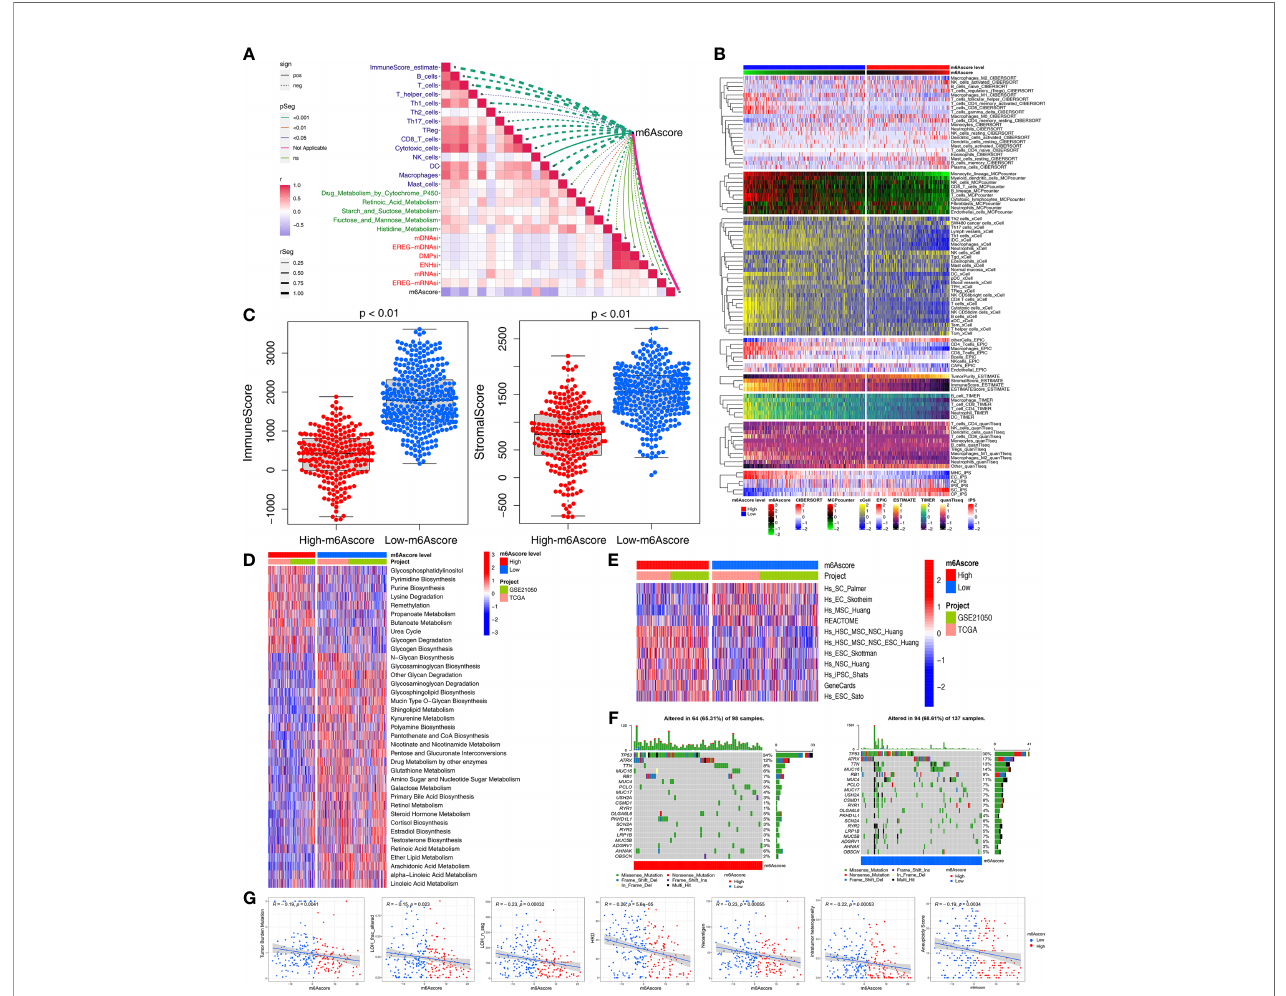
FIGURE 4 | Multiomics analysis of the role of m6Ascore. (A) Correlations between m6Ascore and immune cells, metabolic pathways and stemness index, respectively. (B) Heatmap for immune responses based on CIBERSORT, MCPcounter, xCell, EPIC, TIMER, quanTIseq and iPS algorithms the low- or high- m6Ascore groups. (C) Differences in immuneScore and stromalScore from ESTIMATE algorithms between low- or high-m6Ascore group in the TCGA-SARC and GSE21050 cohort using Kruskal – Wallis test. (D, E) GSVA enrichment analysis showing the activation states of metabolic (D) and stemness-related (E) pathways between high and low m6Ascore groups. The heatmap was used to visualize these pathways, and red represented activated pathways and blue represented inhibited pathways. (F) The waterfall plot showing tumor somatic mutation established by those with high m6Ascore (left) and low m6Ascore (right). Each column represented individual patients. The upper barplot showed TMB, the number on the right indicated the mutation frequency in each gene. (G) Scatter plots depicting the negative correlation by Spearman correlation analysis between m6Ascore and TMB, neoantigen burden, DNA damage including homologous recombination de fi ciency (HRD), loss of heterozygosity (LOH; number of segments with LOH events, and fraction of bases with LOH events), intratumor heterogeneity (ITH), and aneuploidy